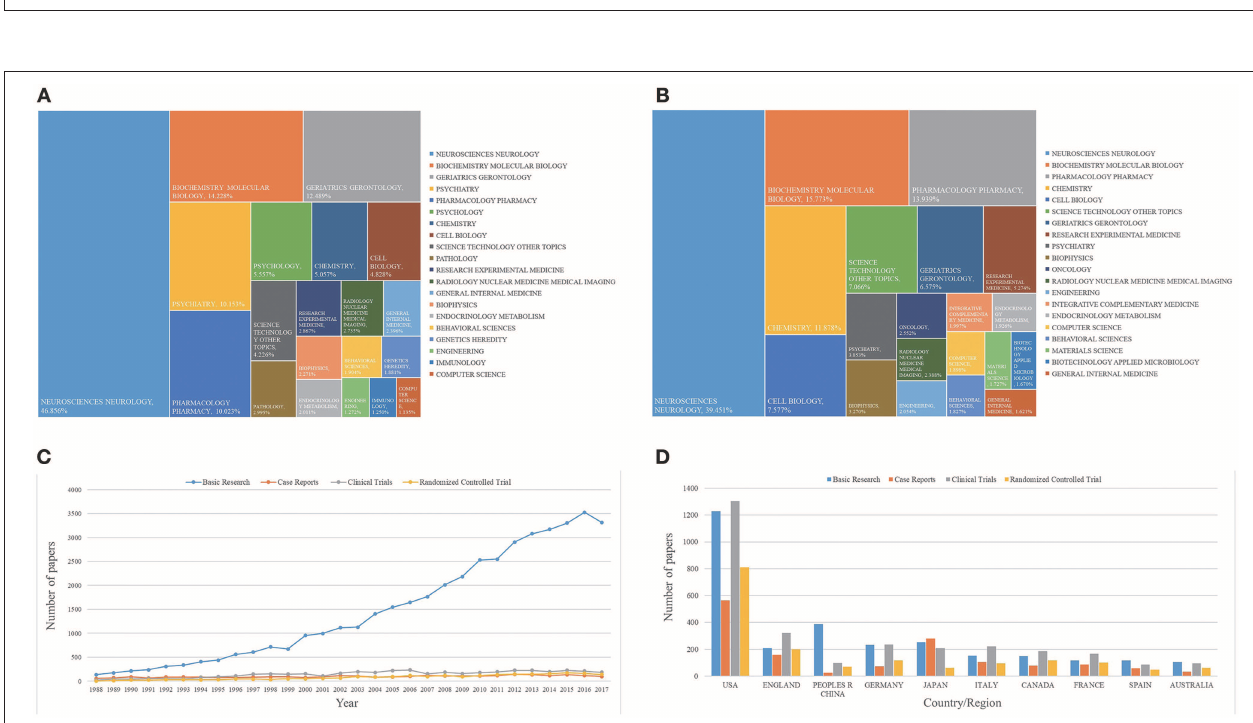
FIGURE 3 | Research categories and article types globally and in China. (A) Research categories and fractions (percentages of research in each category) in global AD research. (B) Research categories and fractions (percentages of research in each category) in Chinese AD research. (C) Randomized controlled trials, clinical trials, case reports, and basic research worldwide from 1988 to 2017. (D) Article type analysis from the top 10 countries by publication volume from 1988 to 2017.